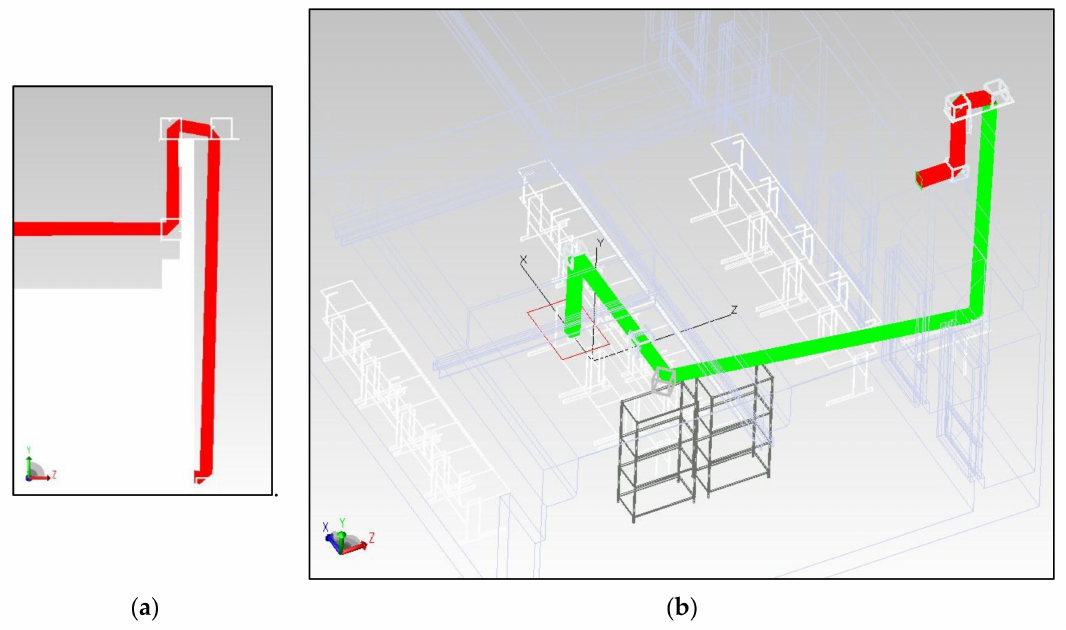
Figure 7. ( a ) Element size simulation diagram; and ( b ) light path simulation